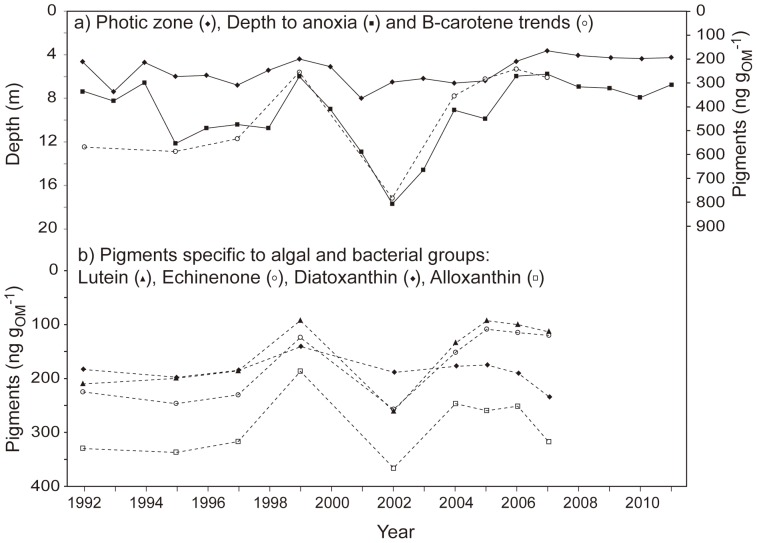
Water column dynamics in Lake Nkuruba 1992–2010.a) annual means of depth to anoxia (squares) and transparency (diamonds), and inferred primary production (circles) expressed as sedimentary concentrations of β-carotene. b) 1992–2007 variations in the concentrations of four sedimentary pigments associated with diatoms (diamonds), cryptophytes (triangles), chlorophytes (squares *concentration values for sedimentary lutein were an order of magnitude higher than the others, and were divided by 10 to fit the graph) and cyanobacteria (circles).